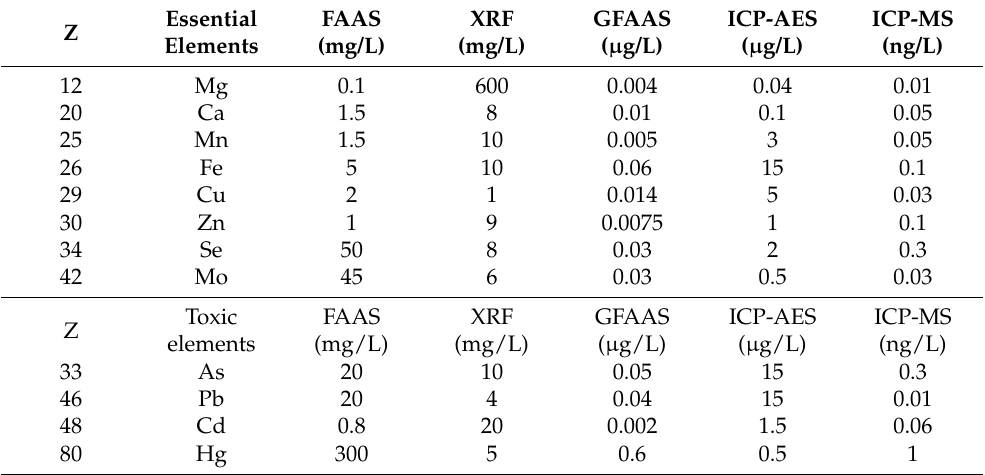
Table 3. Limit of detections of the main essential and toxic elements using the analytical methods: FAAS, XRF, GFAAS, ICP-AES, and